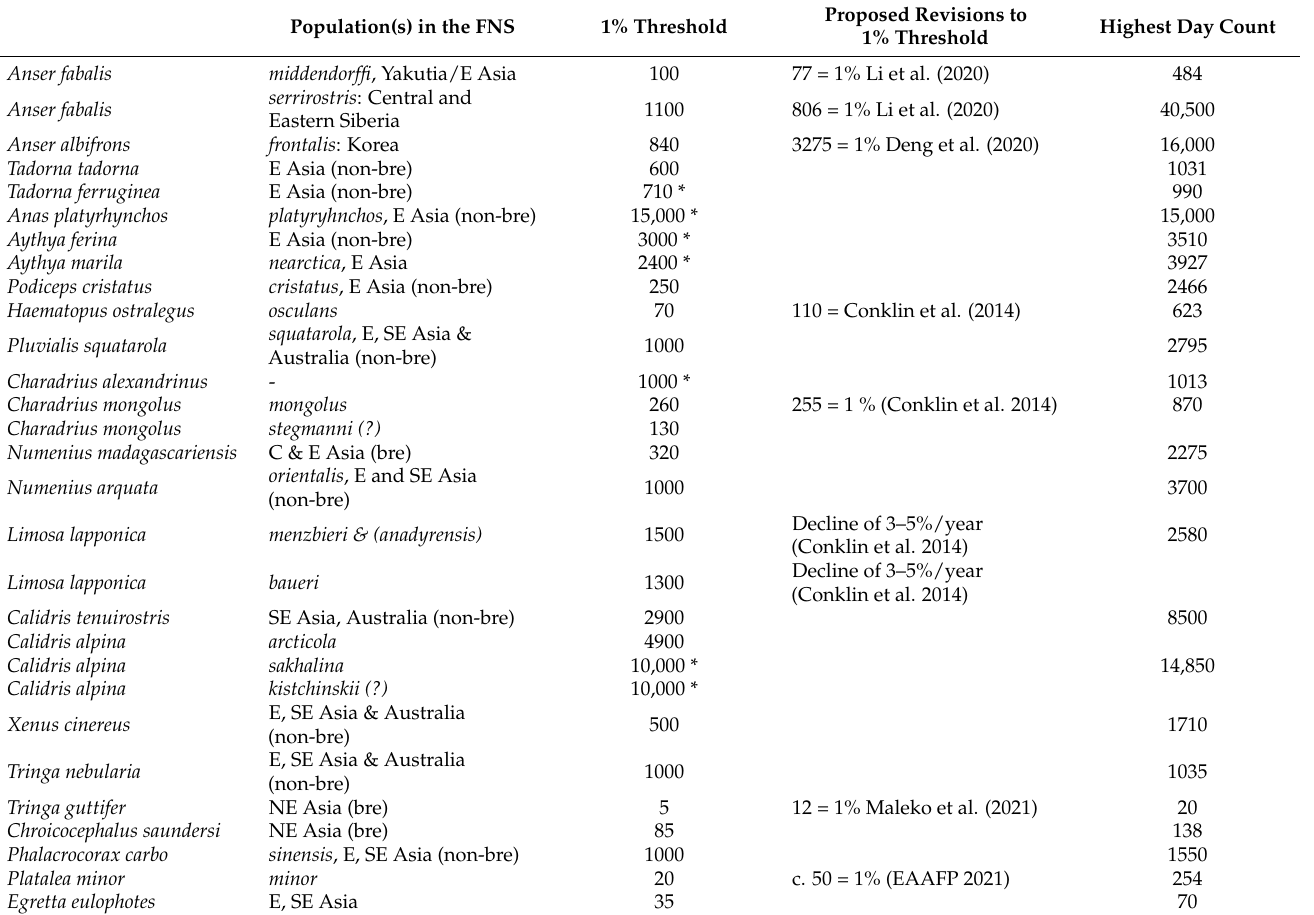
Table A1. One percent threshold and highest day counts of internationally important